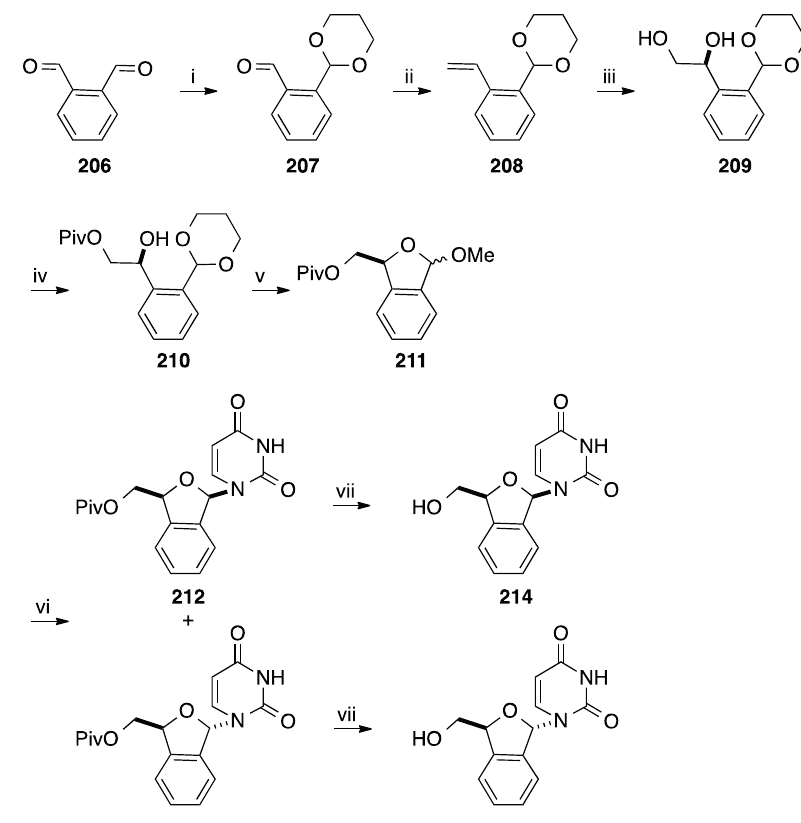
Figure 11. 4'- C -Phenyl purine analogue 205